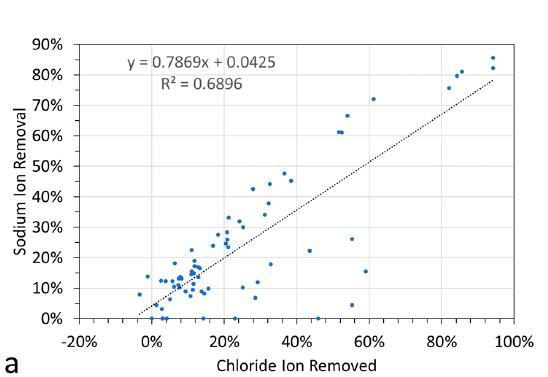
Figure 12. Ion removal: ( a ) chloride; ( b ) sodium.